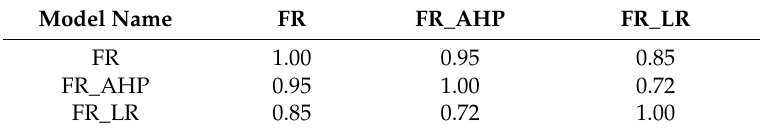
Table 8. Overall correlation between landslide susceptibility